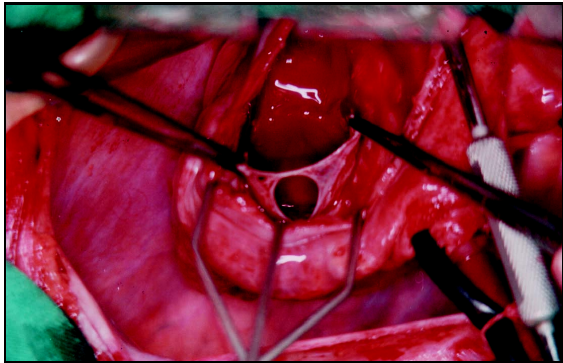
Fig. 2 - Verifica-se a cúspide anterior da valva tricúspide com a fenda central e tendíneas ausência de músculo papilar anterior e de suas cordas